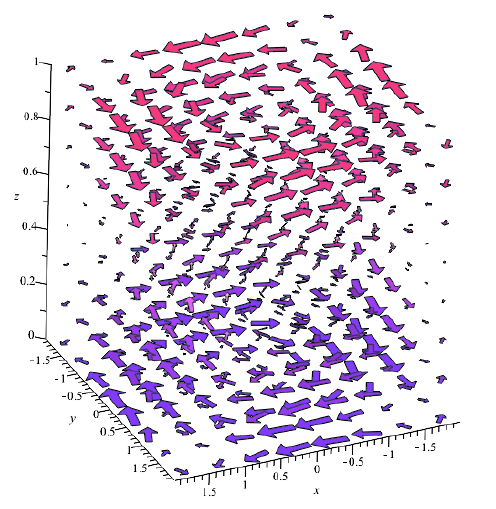
Figure 1. Velocity field of the vortex motion.